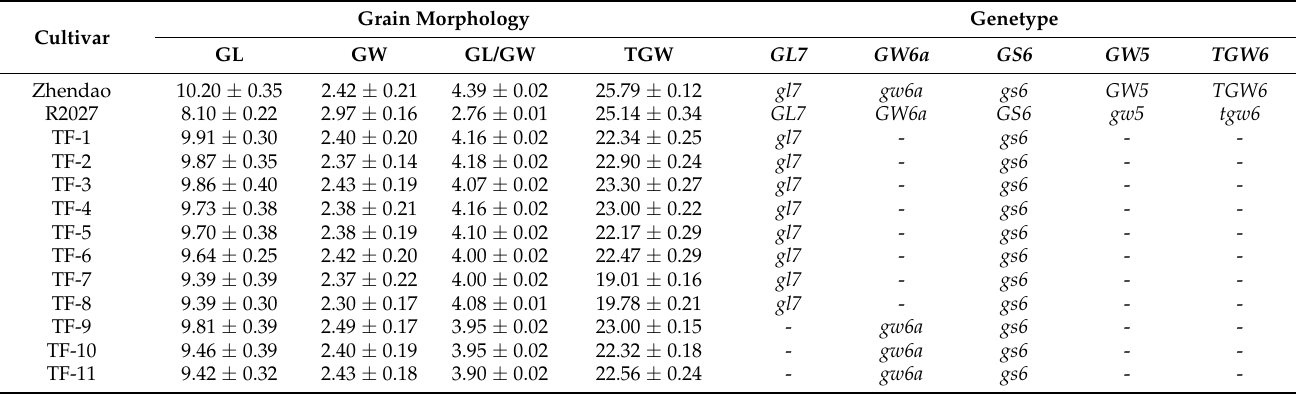
Table 2. Grain-type investigation and grain-size genotyping summary of 36 TF